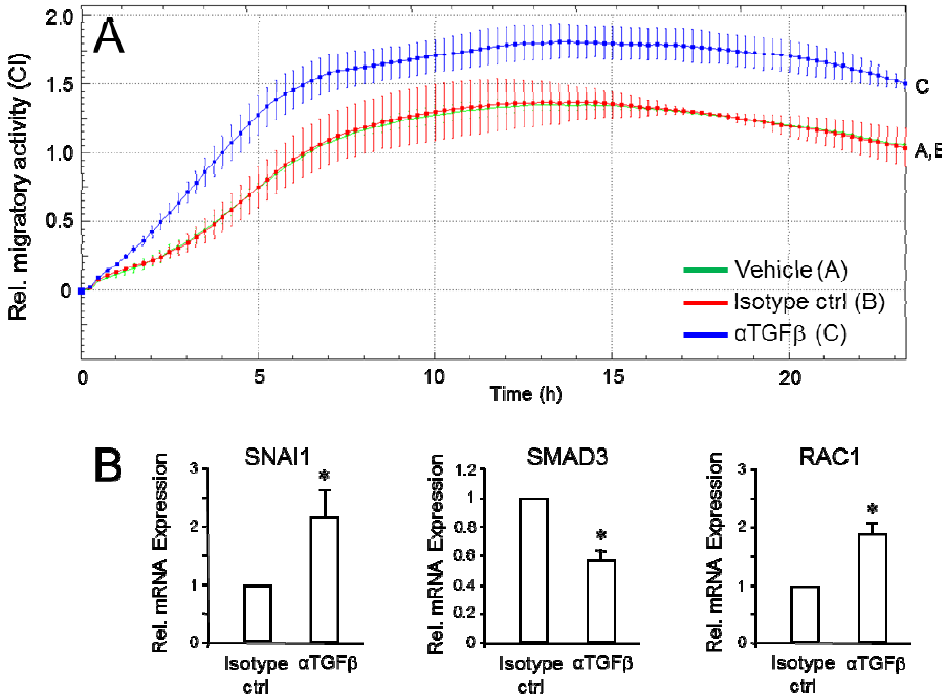
Figure 2. Effects of antibody-mediated neutralization of secreted TGF β on cell motility. ( A ) MDA-MB-231 cells (10,000/well) were subjected to real-time cell migration assay in culture medium (50 µL) containing only 1% fetal bovine serum (FBS) and in the absence or presence of either vehicle, IgG1 isotype control antibody (Isotype ctrl, 5 µg/mL) or pan-anti-TGF β 1/2/3 antibody ( α TGF β , 5 µg/mL). The assays shown are representative of three assays performed in total. Data represent the mean ± SD of three parallel wells. Differences between IgG1 isotype-treated and α TGF β -treated cells were first significant at 2:00 and remained so during the course of the assay. The assay shown is representative of three assays. Data represent the mean ± SD of triplicate wells. ( B ) After completion of the assay shown in ( A ), cells were retrieved from the wells and processed for RNA isolation and qPCR analysis of SNAI1 , SMAD3 or RAC1 . SNAI1 rather than SNAI2 was chosen because of its closer association with invasive vs. non-invasive breast carcinomas [22] and the stronger efficiency and potency to bind to the CDH1 promoter and repress its transcription [23]. ECAD expression remained unaltered. Data represent the mean ± SD of triplicate wells. The asterisks indicate statistical significance relative to isotype ctrl treated cells. * p < 0.05.